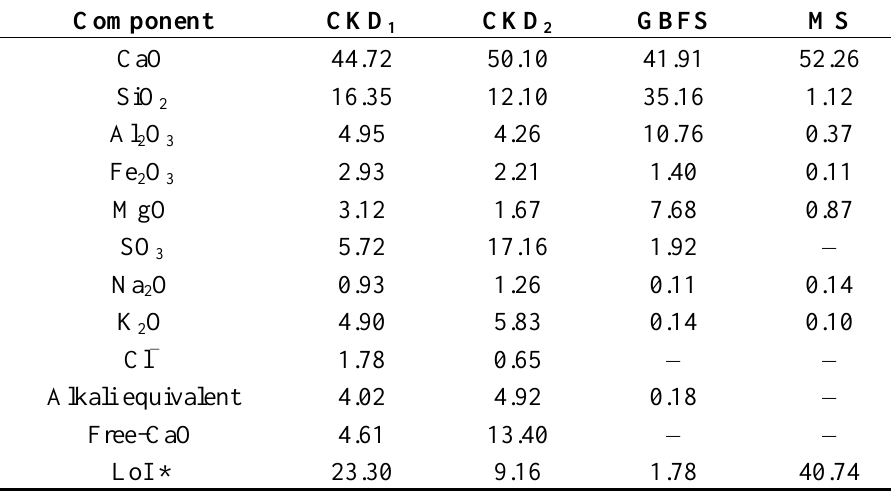
Table 1. Chemical composition of materials (wt